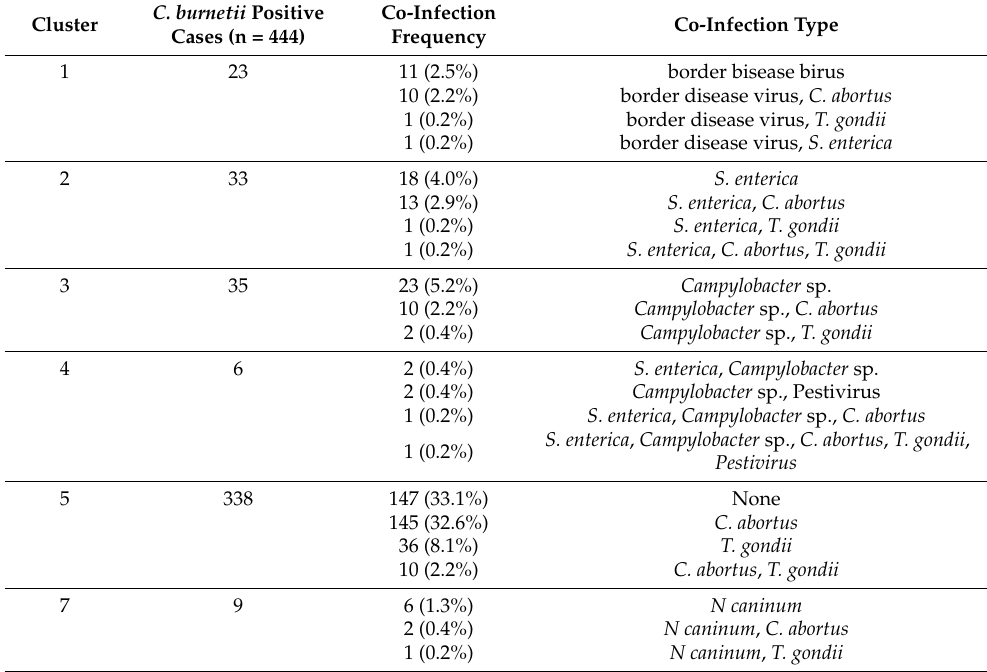
Absence or presence of a particular pathogen is recorded as − and +, respectively. Table 5. Number of ovine abortion cases positive for C. burnetti , and co-infections between C. burnetii and other pathogens in seven clusters indicated in Table 4. Data are count